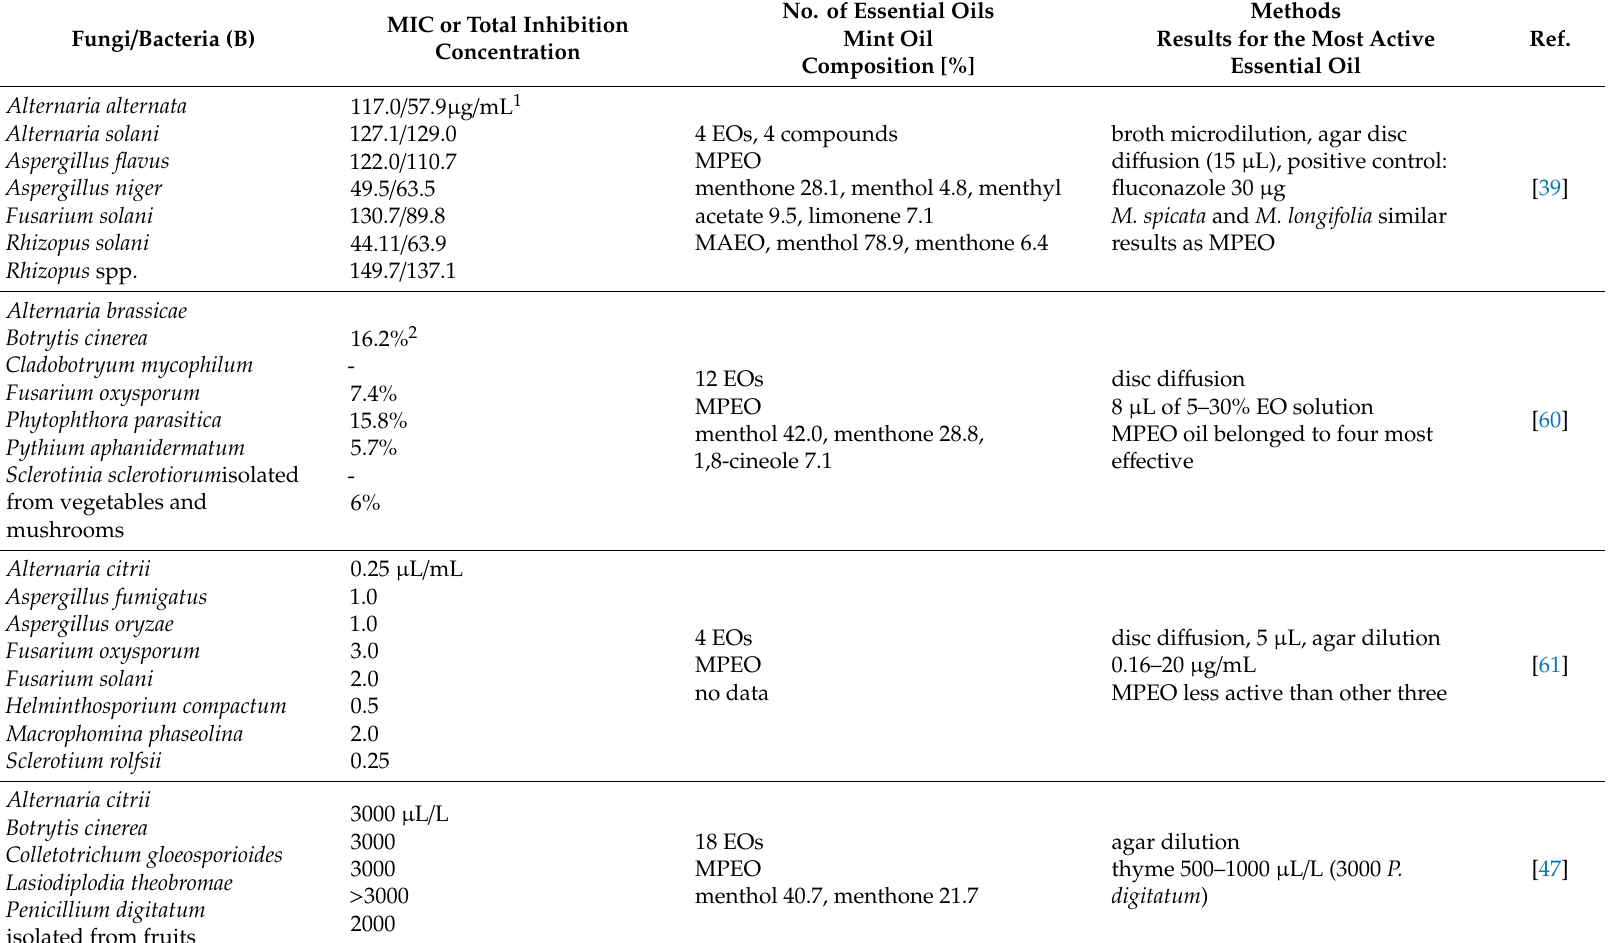
Table 1. In vitro antifungal and antibacterial activity of peppermint oil and cornmint oil against phytopathogens.